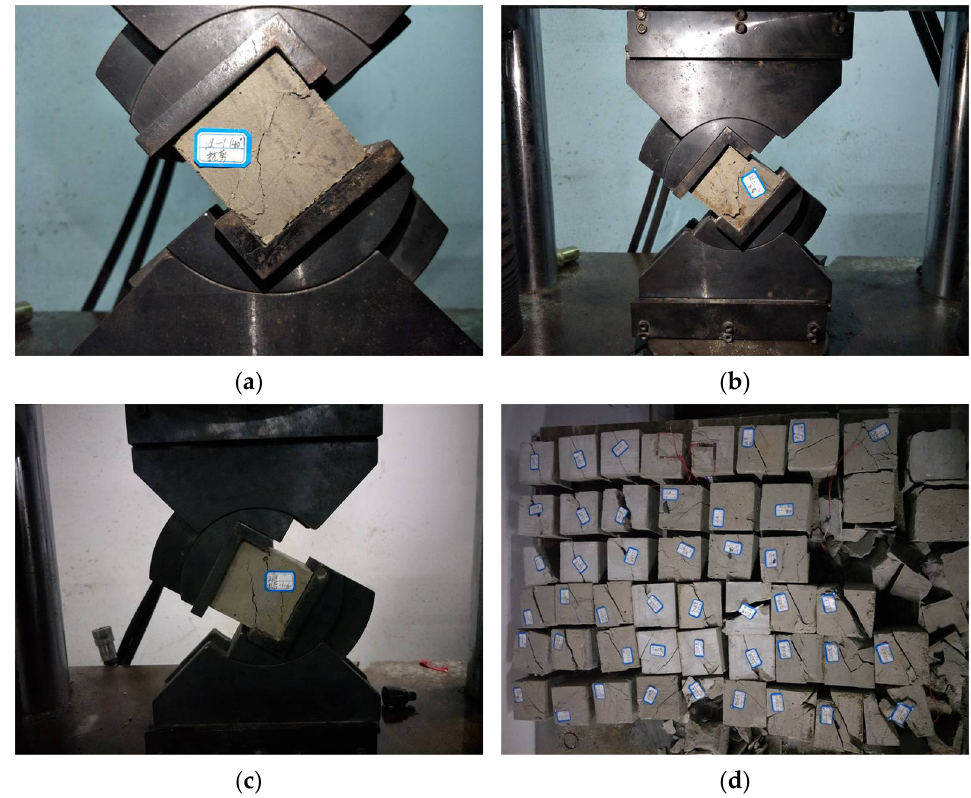
Figure 13. Comparison of specimens at different shear angles. ( a ) Crack at a shear angle of 40; ( b ) Crack at a shear angle of 50°; ( c ) Crack at a shear angle of 60°; ( d ) Specimens after shearing. Table 5. Experimental shear strength values of tested specimens. According to Figure 14, at different shear angles, the shear strength of the shotcrete specimens increased with the curing age and to varying degrees. At shear angles of 40 ◦ , 50 ◦ , and 60 ◦ , the peak shear strength increased by 387.3%, 611.3%, and 596.9%, respectively, compared to 1d. Thus, as the curing age increased, the shear strength of the shotcrete specimen increased most dramatically at a shear angle of 50 ◦ . In addition, as shown in Figure 14b, at a shear angle of 50 ◦ , the peak shear strength of the shotcrete specimen increased most significantly when the curing age was increased from 14 to 28 days.